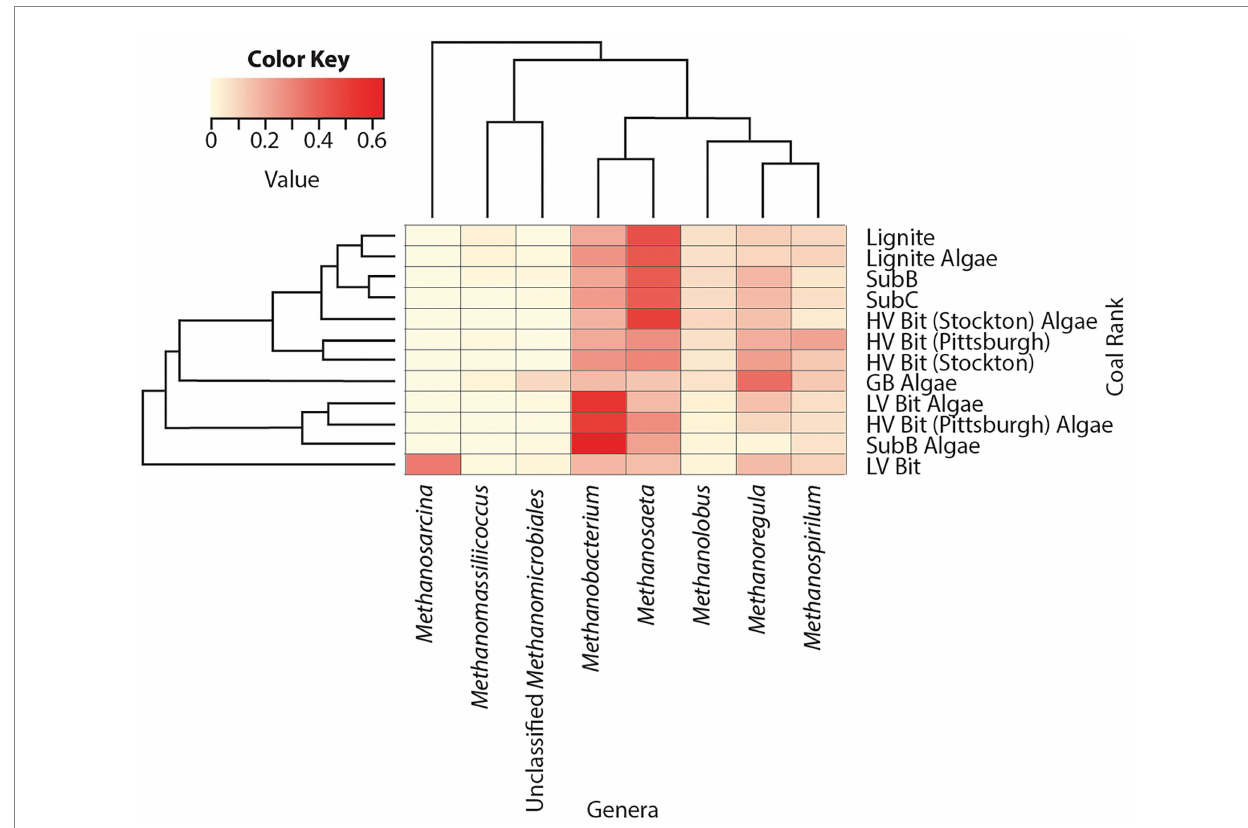
FIGURE 5 Heatmap of archaea relative abundance of OTUs combined by phylotype. Phylotypes without a relative abundance of 2.5% in at least one sample were